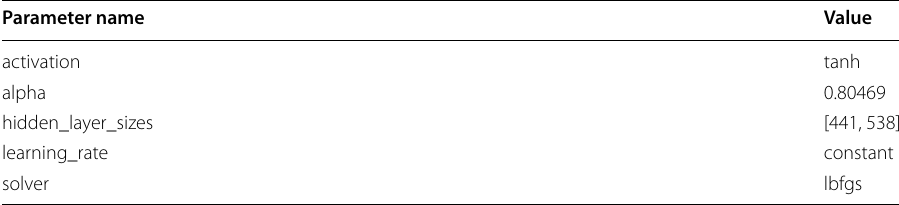
Table 65 Modes of MLP tuned hyperparameter values for experiments with the information theft